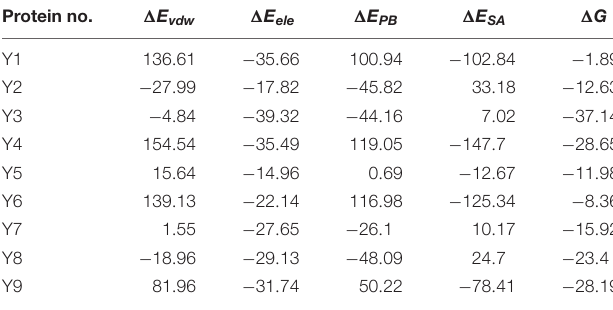
TABLE 1 | The binding free energy (kcal/mol) of drug with nine homology models. Protein